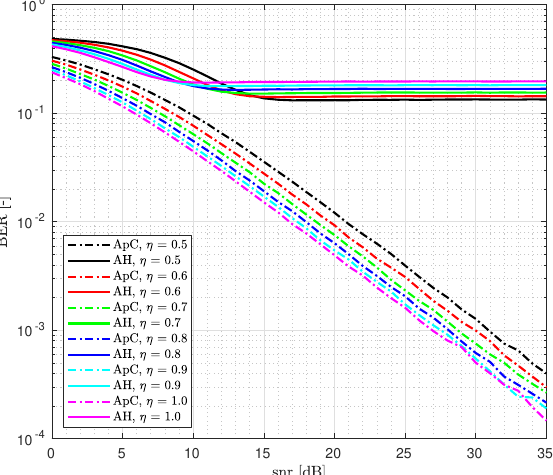
Figure 7. H-BER of AH differential detector vs. ApC detector in Rayleigh fading